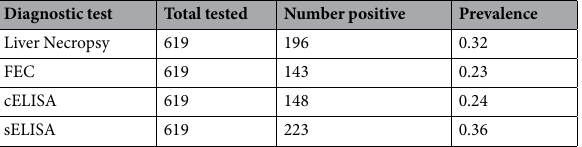
Table 2. Number of animals tested and the measured prevalence for each of the four types of diagnostic tests